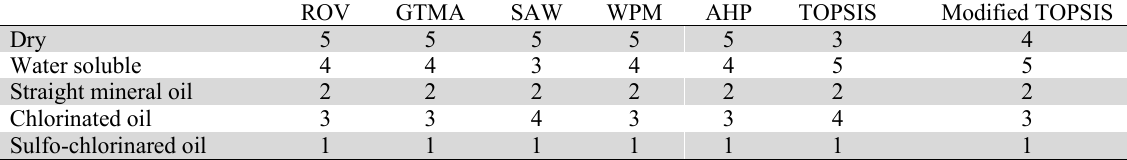
Rankings of the cutting fluids obtained using different MCDM methods